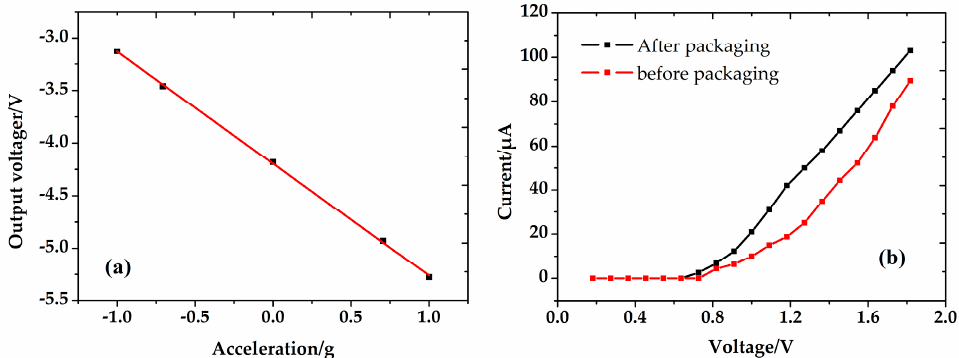
Figure 12. Performance of the accelerometer. ( a ) The output fitting curve of acceleration and output voltage; ( b ) I / V characteristic of accelerometer.